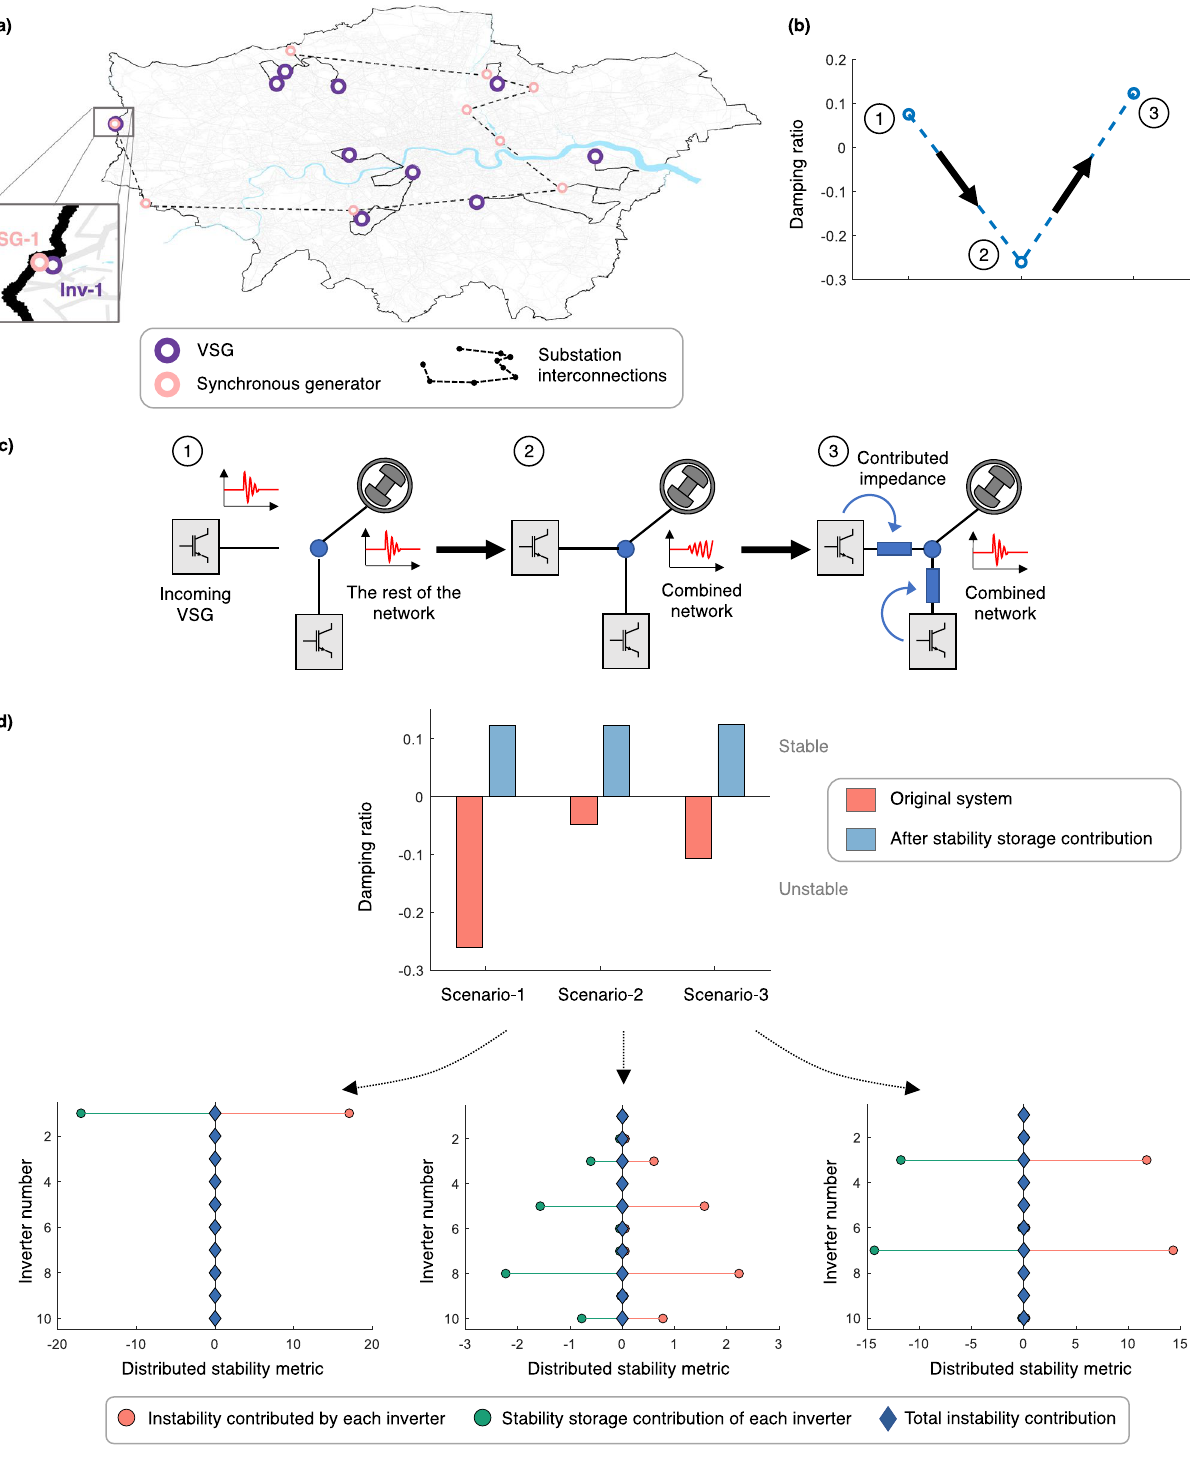
Figure 4. Using VSGs as stability stores to expand inverter-based generation in the power grid. ( a ) Location of the rotating and virtual synchronous generators in Scenario-1 from Fig. 2, showing the addition of a new VSG, named Inv-1. ( b ) Damping ratio in ( a ) before and after the addition of Inv-1. Also shown is the damping ratio after all VSGs contribute stability storage. ( c ) Illustrating how a new VSG can be added to the grid while preserving stability. The following sequence is depicted: an incoming VSG is to be added to a stable grid; the combined network becomes unstable as a result; and the combined network regains its stability after the VSGs participate as stability stores. ( d ) Damping ratio for the three unstable scenarios in Fig. 2 before and after all inverters provide stability storage. Also shown is the contribution of each inverter to the instability of the grid, and the effect of stability storage in mitigating the respective instability contributions. The incentive provided to each inverter for its service is proportional to the stability storage